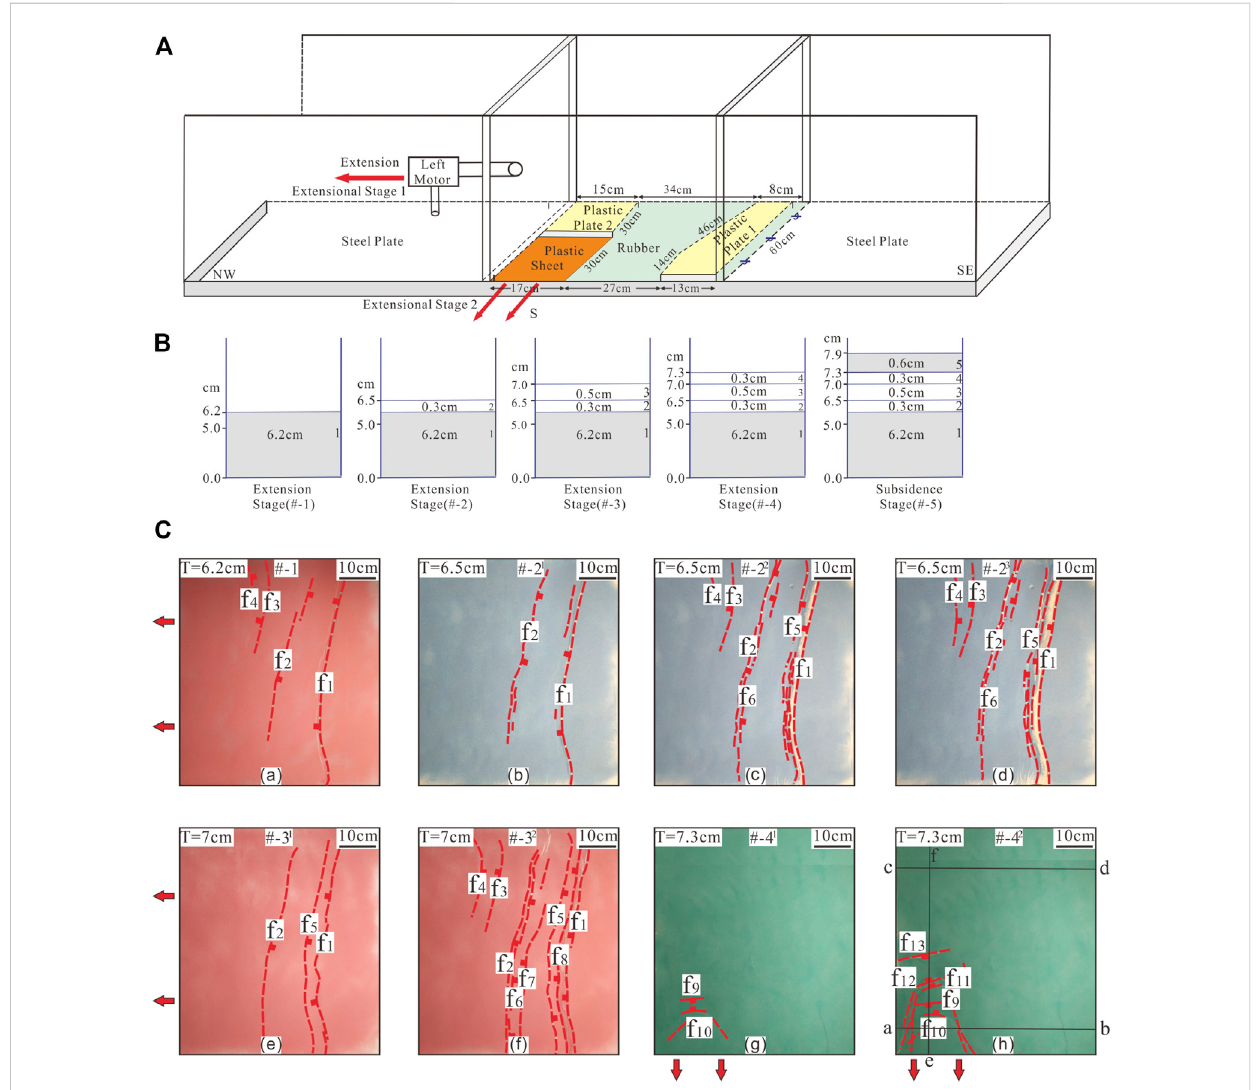
FIGURE 11 (A) Model setup showing a 3D view of the deformation rig and its components for modeling the evolution of the Panyu 4 Sag from the middle EocenetotheOligocene; (B) Thesketchtoshowsthe fi llingprocessofthemodelatdifferentstages.Theredsolidarrowsrepresentthestressdirectionin the extension stages; (C) Top view (photographs and line drawings) of different stages of the model showing the evolution of the Panyu 4 Sag from the extension stage 1 (a-f) to the extension stage 2 (g-h) . T denotes the total thickness of the sand layers; # denotes the deformation phase of the simulation process; the fault label numbers represent the order of the faults developed in the